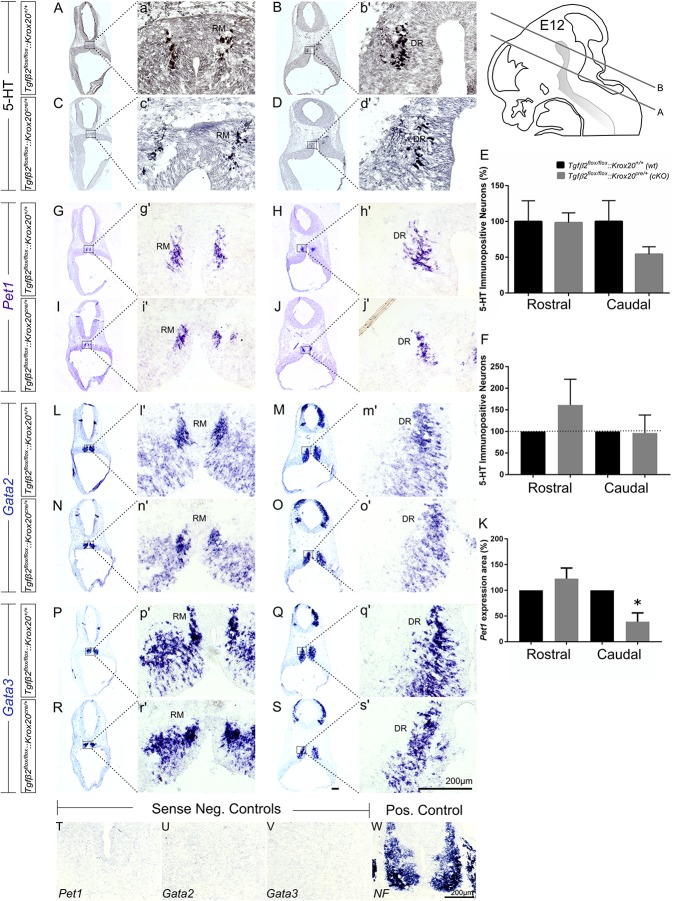
Phenotype analysis of Tgfβ2flox/flox:Krox20cre/+ hindbrain at embryonic day 12 (E12). Immunoperoxidase light microscopy for rostral DR (B,D) and caudal RM (A,C) serotonergic neurons (5-HT positive) of Tgfβ2flox/flox:Krox20+/+ (wt) and Tgfβ2flox/flox:Krox20cre/+ (cKO) at E12. (a′–d′) Represent higher magnification of the respective black-boxed areas in (A–D). (E,F) Counting of 5-HT positive cells after immunostaining in hindbrain tissue sections revealed no differences in the number hindbrain rostral and caudal serotonergic neurons between wild type (wt) and Tgfβ2flox/flox:Krox20cre/+. Not significant, using the two-tailed unpaired Student’s t-test (caudal) and Mann–Whitney Rank Sum Test (rostral), n = 5–7. Data are given as mean ± SEM, the mean of wt was set to 100 (E) or the mean of littermate was set to 100 (F). ISH for expression of the serotonergic marker Pet1
(G–J,g′–j′) using antisense probe on coronal fixed tissue cryosections from wt and Tgfβ2flox/flox:Krox20cre/+ mouse embryos. (K)
Pet1 expression area in cKO was significantly decreased in the caudal hindbrain (∗p < 0.05, using the two-tailed unpaired Student’s t-test, n = 3). Data are given as mean ± SEM, the mean of wt littermate was set to 100. ISH for the early serotonergic markers Gata2
(L–O,l′–o′) and Gata3
(P–S,p′–s′). (T–W) Represent the negative and positive controls for (G–S). NF, neurofilament. Scale bar: 200 μm.